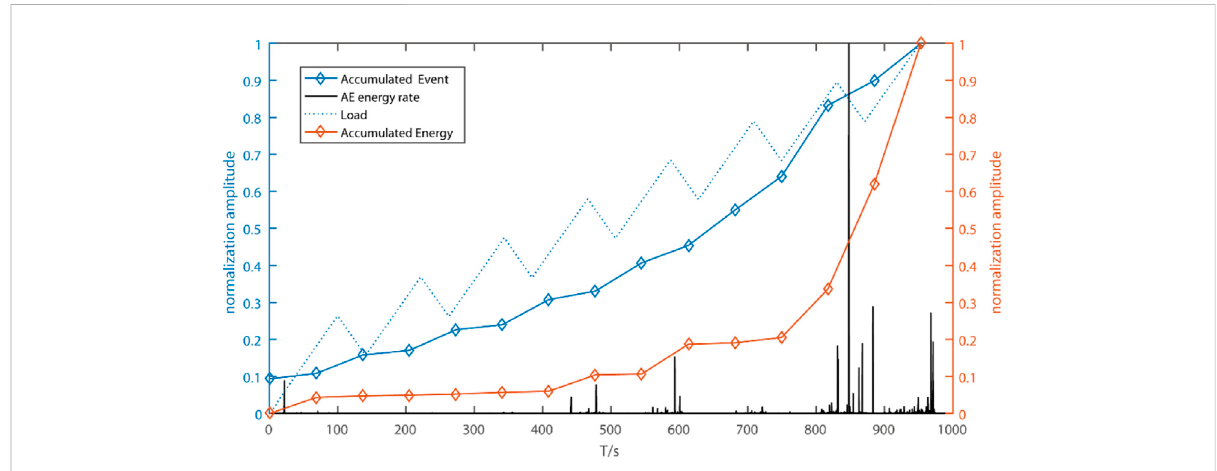
FIGURE 7 Acoustic emission energy release and cumulative event rate.